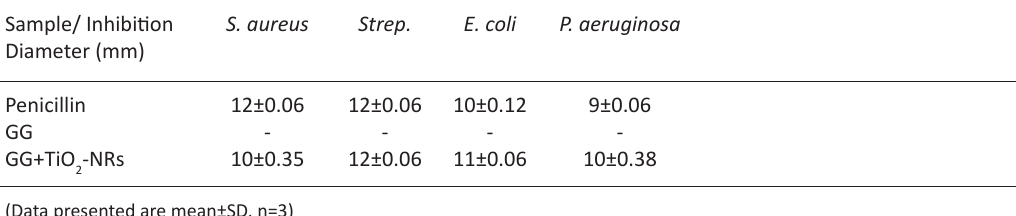
Table 1. Inhibition zone of films against Staphylococcus aureus, Streptococcus, Escherichia coli, and Pseudomonas aeruginosa Sample/